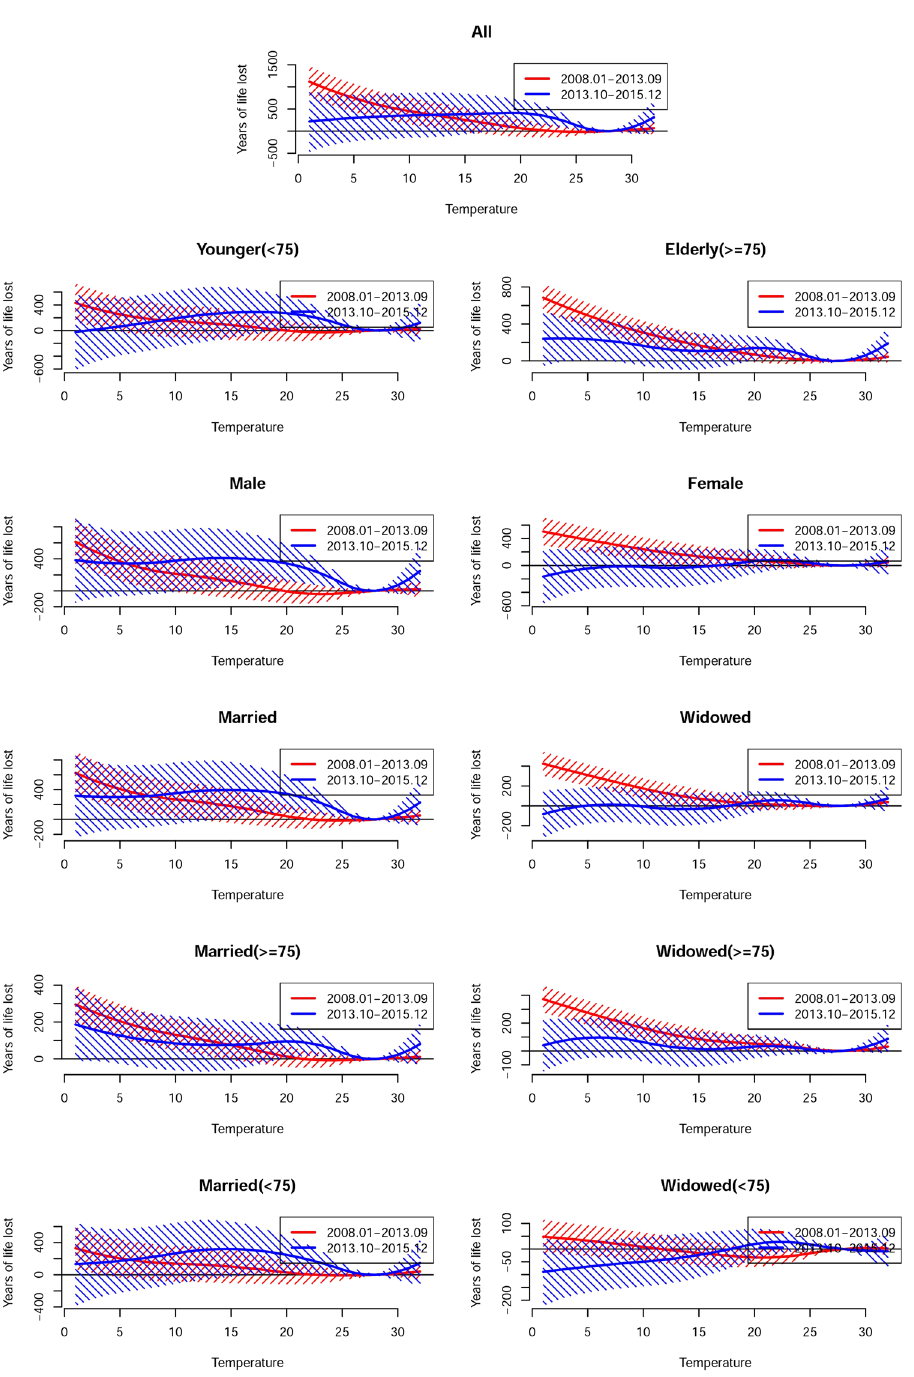
Figure 3. Overall cumulative exposure-response curves (with 95% confidence intervals) for the association between temperature and years of life lost due to non-accidental mortality during period I (Jan 2008 to Sep 2013, red) and period II (Oct 2013 to Dec 2015,